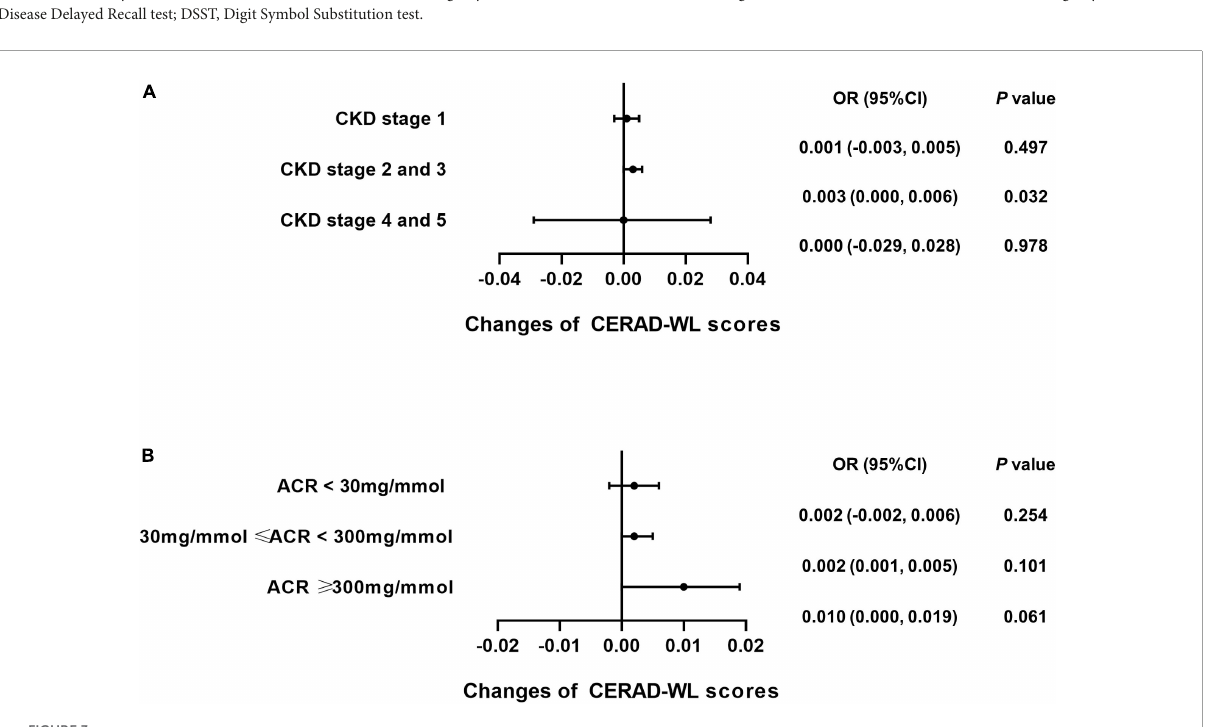
FIGURE3 Caffeine intake improves performance on the Consortium to Establish a Registry for Alzheimer’s Disease Word Learning Test (CERAD-WL) for CKD stage 2 and 3 patients. To investigate whether CKD stages and urinary albumin creatinine ratio (ACR) levels influence the beneficial effects of caffeine intake on CERAD-WL in CKD patients, subgroup analysis was performed. Logistic regression analysis of caffeine intake and CERAD-WL scores was performed in each CKD stage subgroup (CKD stage 1 = 59 subjects, CKD stage 2 and 3 = 362 subjects, CKD stage 4 and 5 = 21 subjects) or each ACR subgroup (ACR < 30 mg/mmol = 196 subjects, 30 mg/mmol ≤ ACR < 300 mg/mmol = 210 subjects, ACR ≥ 300 mg/mmol = 36 subjects). Caffeine intake significantly improved the performance on the CERAD-WL in CKD stage 2 and 3